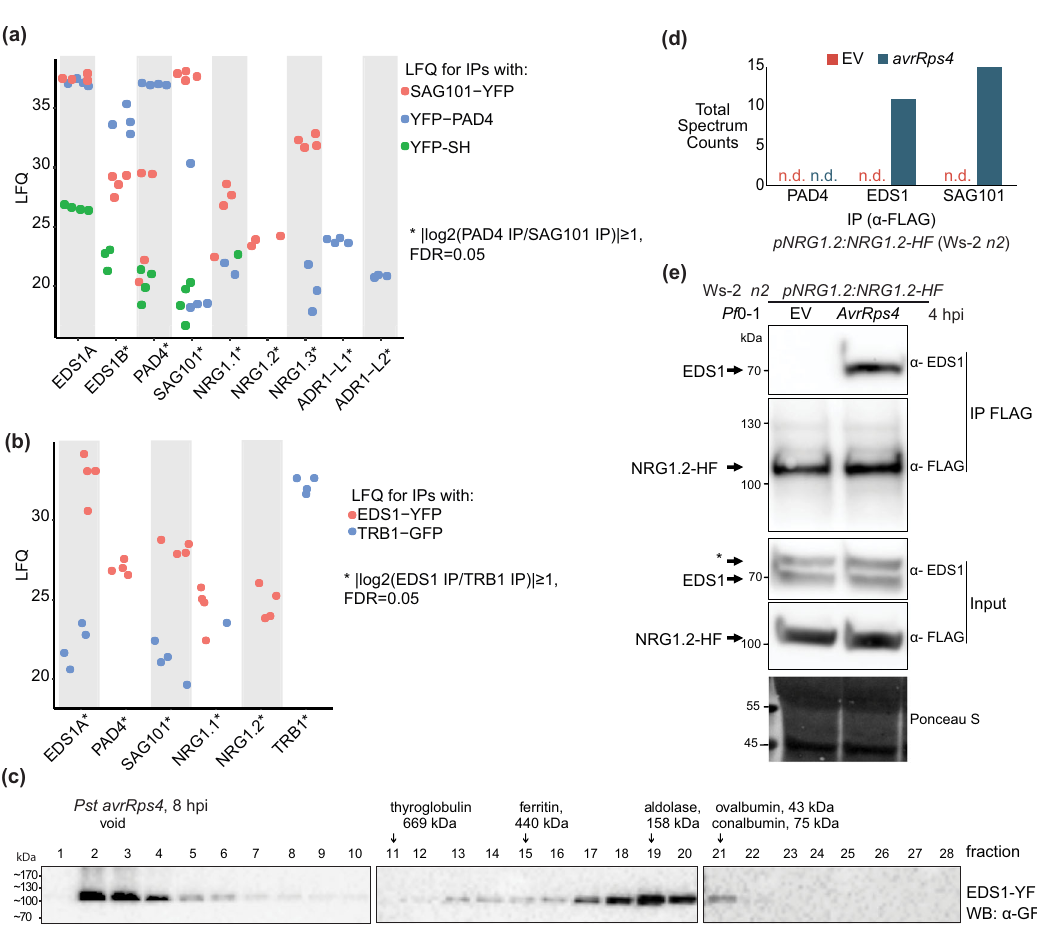
Fig. 3 Early effector-dependent NRG1 association with EDS1 and SAG101 in Arabidopsis TNL RRS1 – RPS4 triggered ETI. a Dotplot of normalised abundance values (label-free quanti fi cation (LFQ), log 2 -scaled) for proteins detected in liquid chromatography – mass spectrometry (LC – MS) analyses after α -GFP immunoprecipitation (IP) of PAD4-YFP or SAG101-YFP from total leaf extracts of respective complementation lines pPAD4:YFP-PAD4 and pSAG101: SAG101-YFP (both Col pad4 sag101 background) after in fi ltration with effector tester stra5in of Pseudomonas fl uorescens 0-1 ( Pf 0-1) avrRps4 (6 hpi, OD 600 = 0.2). ADR1s are speci fi cally enriched in PAD4-YFP IP samples, whereas NRG1s are more abundant in the SAG101-YFP IP samples. Samples were collected from four independent experiments. b Dotplot of LFQ values for proteins detected in LC – MS analyses after IP of EDS1-YFP and TRB1-GFP from nuclei- enriched extracts of corresponding Arabidopsis complementation lines in fi ltrated with Pseudomonas syringae pv. tomato DC3000 ( Pst ) avrRps4 (8 hpi, OD 600 = 0.1). NRG1.1 and NRG1.2 are speci fi cally enriched in EDS1-YFP samples. Samples were collected from four independent experiments. c α -GFP probed immunoblots of nuclei-enriched extracts from leaves of the Arabidopsis pEDS1:EDS1-YFP complementation line (Col eds1-2 background) in fi ltrated with Pst avrRps4 (OD 600 = 0.1, 8 hpi). Extracts were resolved using native gel fi ltration. Arrows below protein markers indicate position of